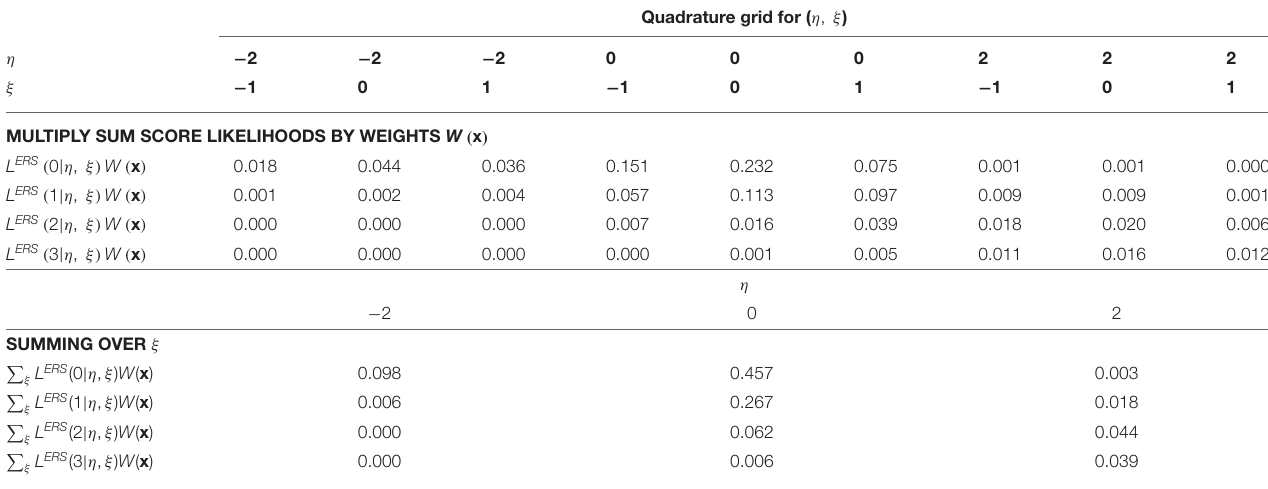
Quadrature grid for ( η , ξ